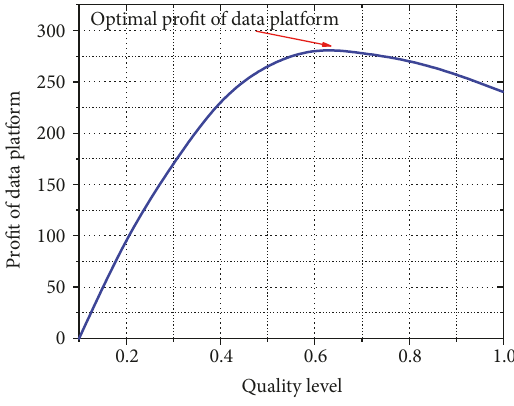
Figure 7: Data platform profits under different quality levels.